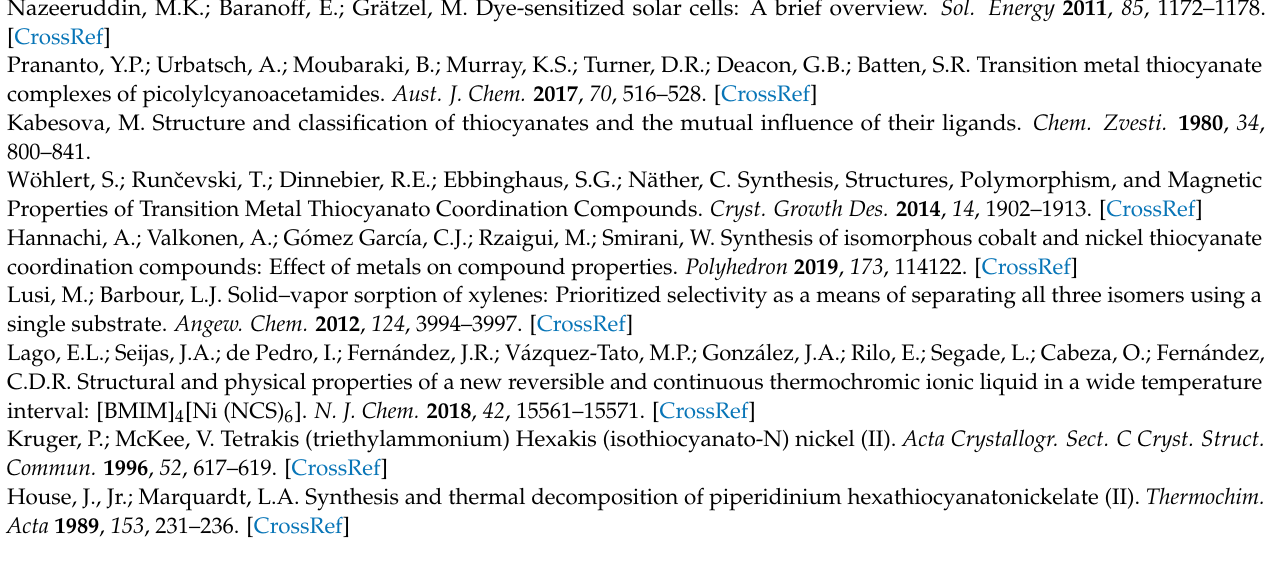
Table S3: Atomic coordinates and isotropic displacement parameters (in Å 2 ) at 293 K; Table S4: Atomic coordinates and isotropic displacement parameters (in Å 2 ) at 120 K; Table S5: Anisotropic displacement parameters (in Å 2 ) at 293 K; Table S6: Anisotropic displacement parameters (in Å 2 ) at 120